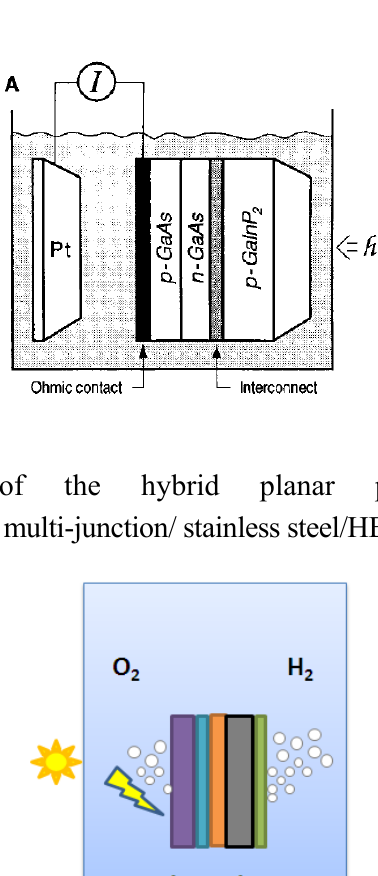
Figure 11. Schematic of the monolithic PEC/PV device Reproduced with permission from ref [73]; published by (The American Association for the Advancement of Science), (1998).